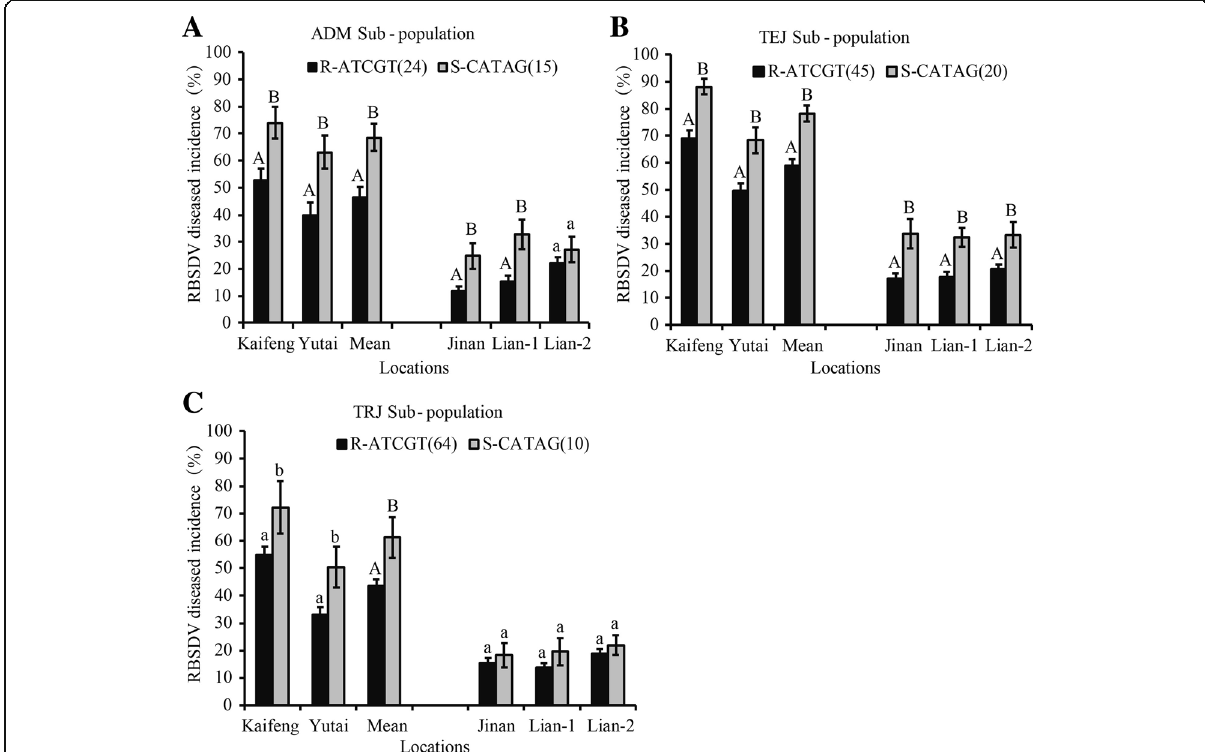
Fig. 5 Resistance comparison of the varieties with different haplotypes formed by 5 significant association SNP markers. a-c Resistance comparison of different haplotypes in ADM ( a ), TEJ ( b ) and TRJ ( c ) sub-populations. The haplotypes were formed from the 5 significant association SNP markers in the order of id6010277, id6010459, id6010472, id6010489 and id6010523 on chromosome 6. R-ATCGT and S-CATAG indicate resistant (favorable) and susceptible (unfavorable) haplotypes, respectively. The number following R-ATCGT or S-CATAG indicates the number of varieties having this haplotype. Different capital and lowercase letters above columns indicate 1% and 5% statistically significant difference, respectively. RBSDV, rice black-streaked dwarf virus; ADM, Admixture; TEJ, temperate japonica ; TRJ, tropical